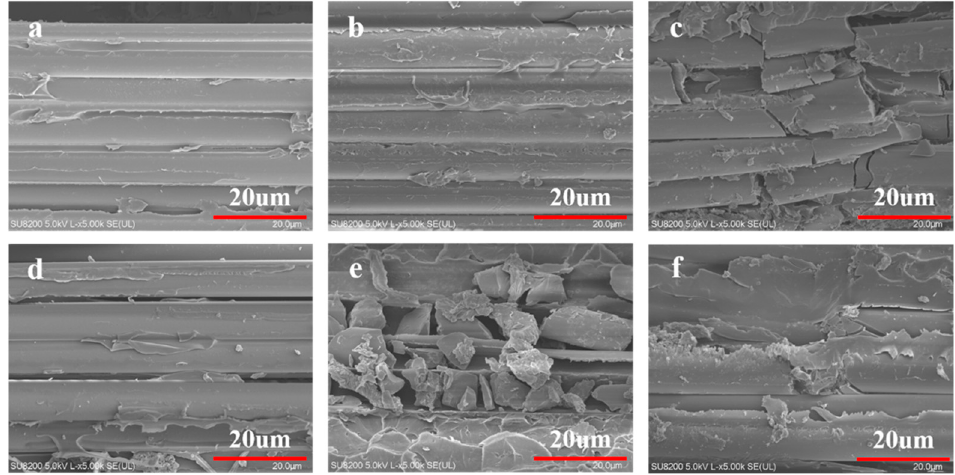
Figure 8. SEM images of compression failure sample; ( a ) BF—Desized/PPENK, ( b ) BF-PVP/PPENK, ( c ) BF-PEN/PPENK, ( d ) BF-PPEK/PPENK, ( e ) BF-PPEN/PPENK and ( f ) BF-PPENK/PPENK composites.